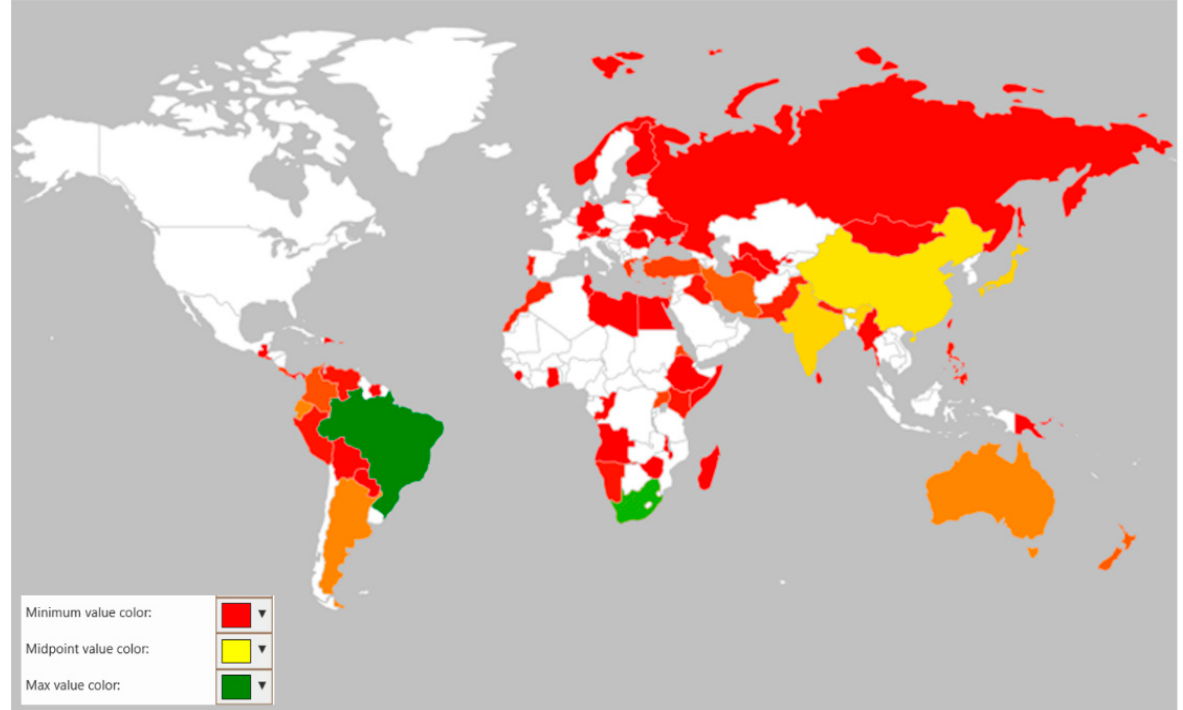
Figure 9. Geographical heat map showing distribution of endemic / native Uromyces species.